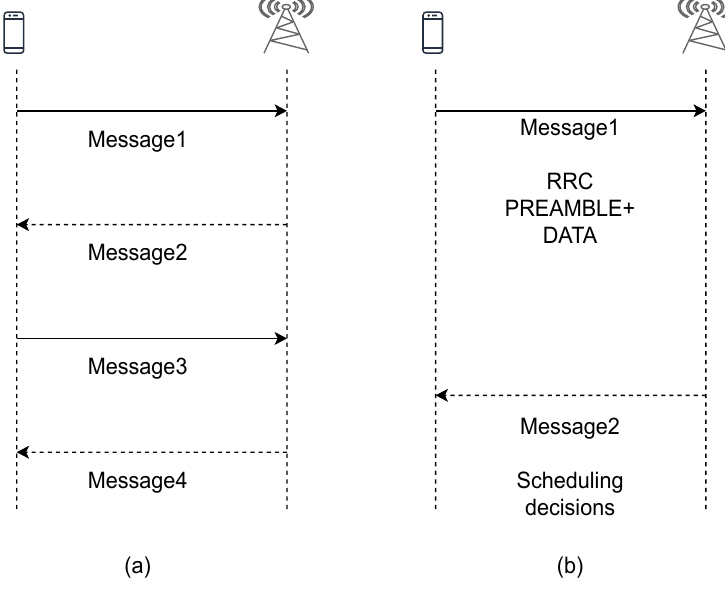
Figure 2. Procedure of RA: ( a ) LTE; ( b ) 5G